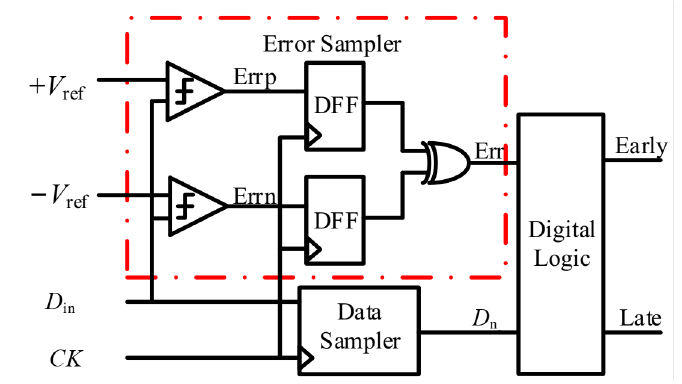
Figure 1. Mueller–Muller PD